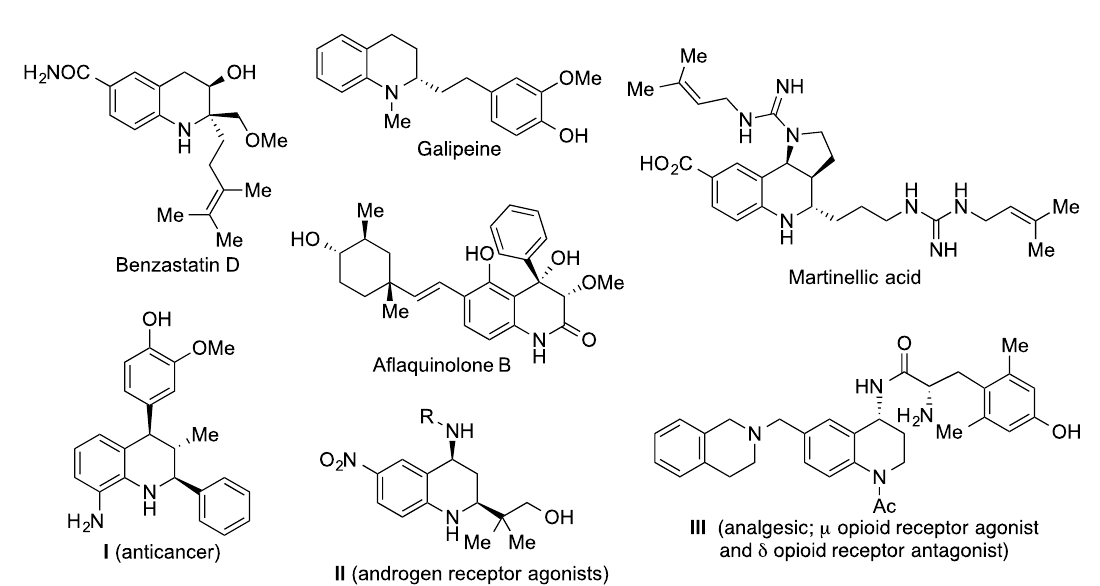
Molecules 2021 , 26 , x FOR PEER REVIEW